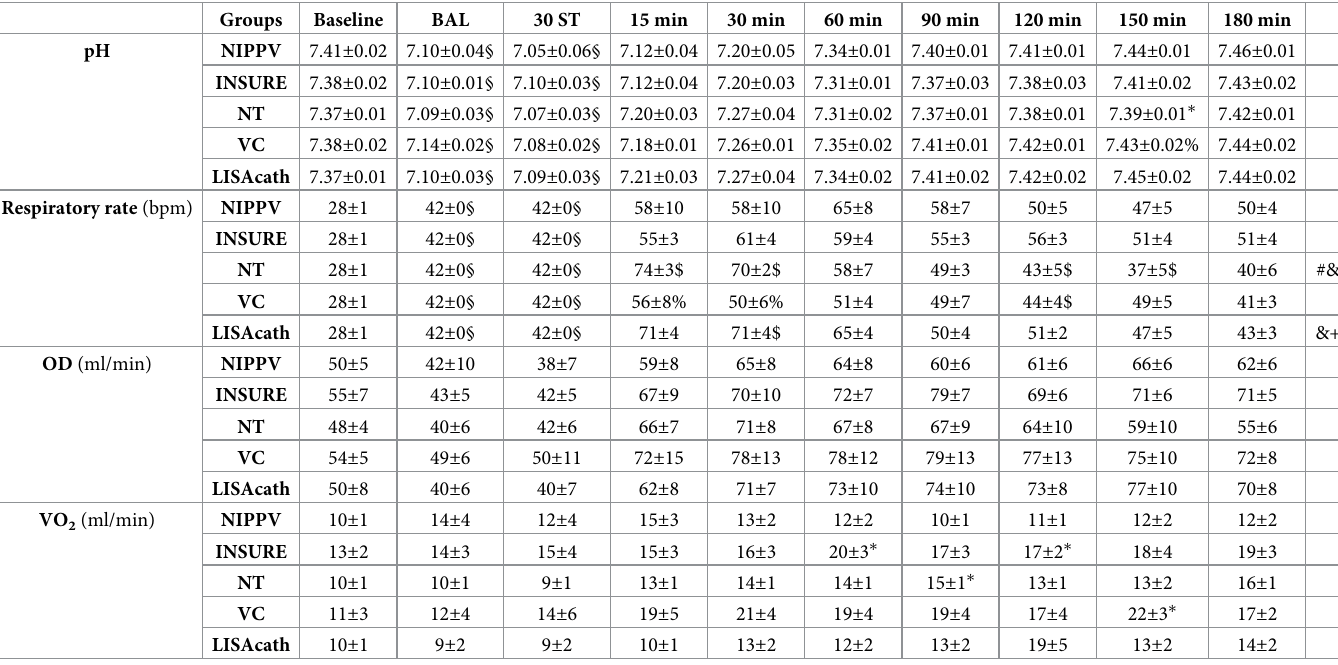
Table 1. pH, respiratory rate and oxygen metabolism in bronchoalveolar lavage-induced respiratory distress newborn piglets treated with nasal intermittent posi- tive pressure ventilation (NIPPV) without SF therapy or with SF therapy, using the INSURE-like method, less-invasive SF administration (LISA) with a nasogastric tube (NT), LISA with a vascular catheter (VC) or LISA with the LISAcath 1 catheter over the 180-min treatment period. Groups